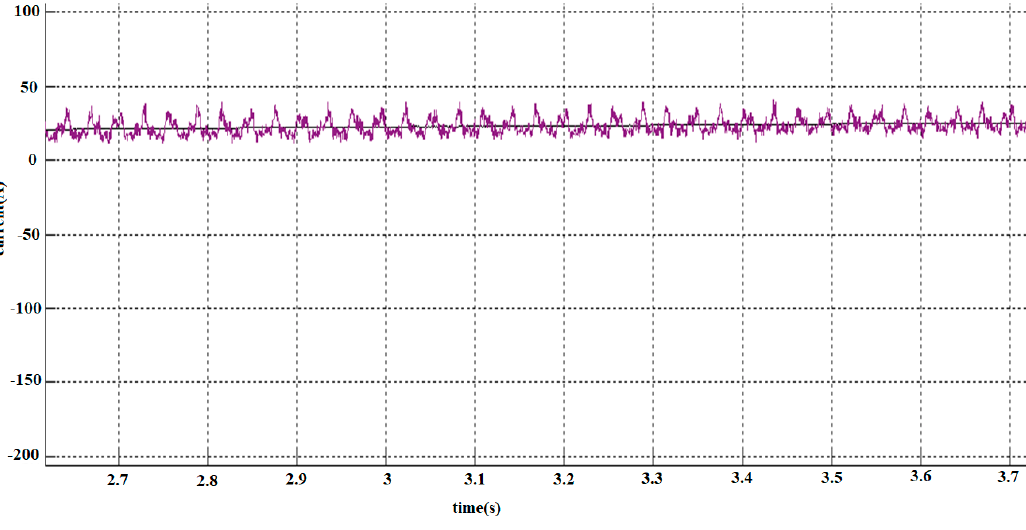
Figure 17. Output-side d axis current. Figure 18. Output-side q axis current.